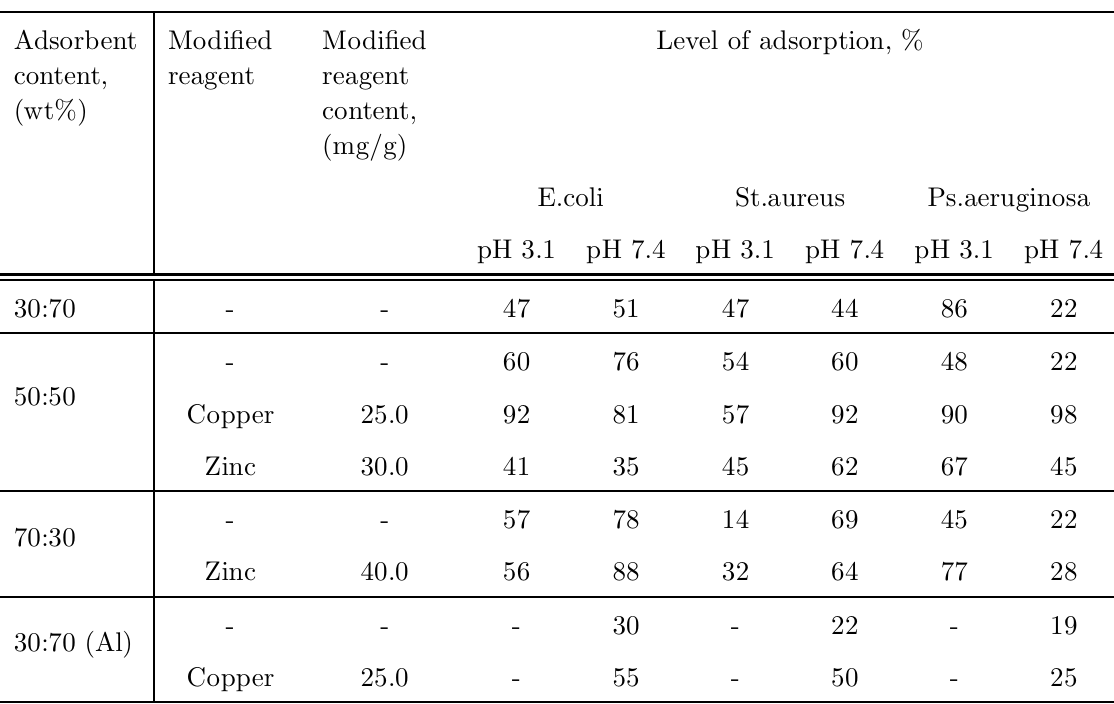
Table 6 Adsorption capacity of silico-polimethylsiloxane and their metalcontaining forms to- wards pathogenic